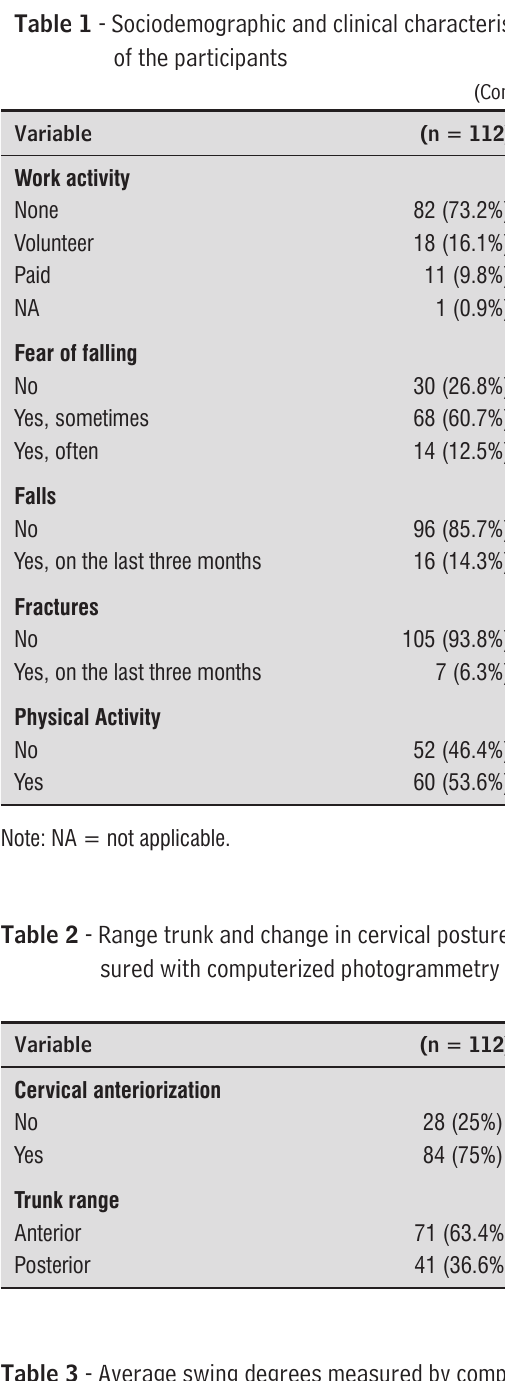
Table 3 - Average swing degrees measured by computer photogrammetry and